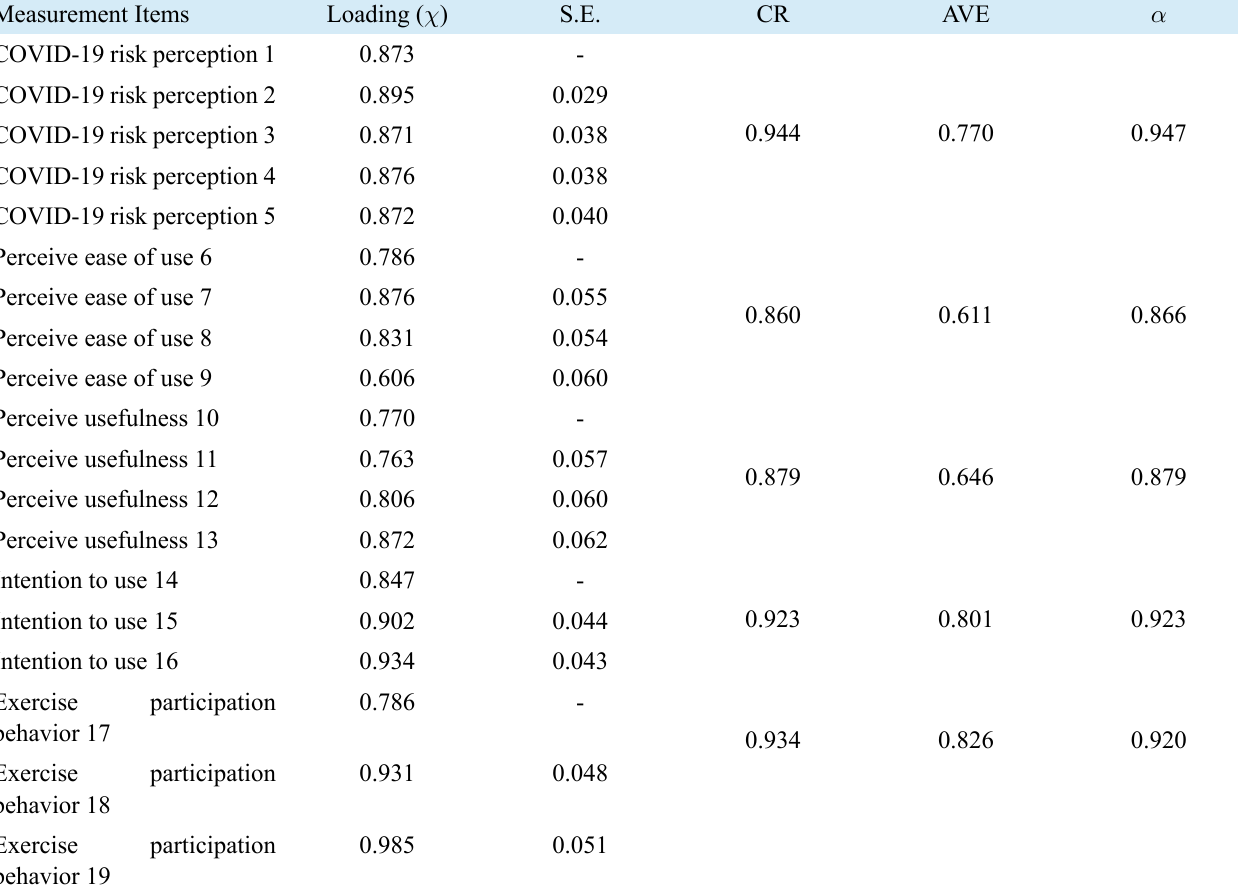
TABLE 2. Results of the validity and reliability analyses.